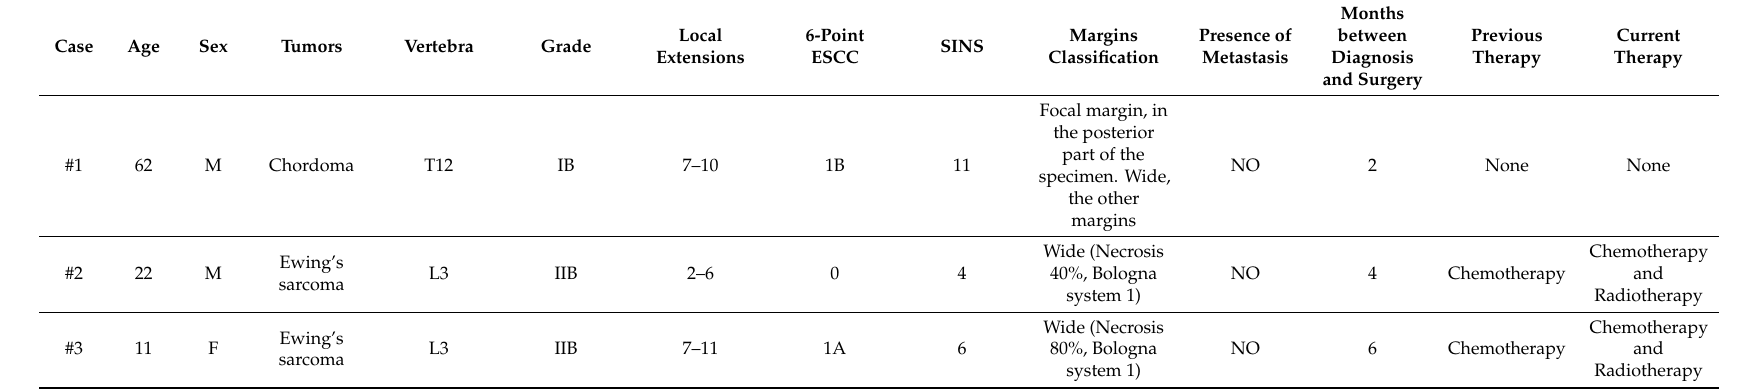
Table 1. Patients’ and tumors’ details. In particular, for each case, the following details were evaluated: surgical stage (Enneking Classification) [13], tumor extension (WBB Classification) [14], epidural spinal cord compression (Bilsky Classification) [15], spine instability neoplastic score [4], and margin classification (and for the Ewing’s sarcoma also the prognostic indicator